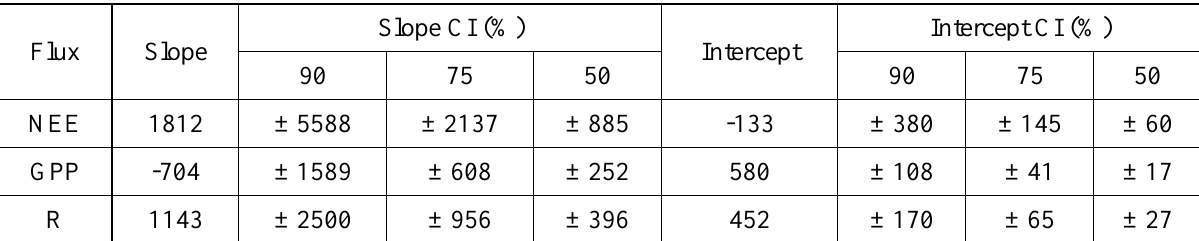
Table 2. Fitted slope and intercept coefficients with confidence intervals at 90, 75 and 50 %. Fits are provided for dependent variables (y): NEE, GPP and R. The independent variable (x) was the reciprocal of the time since restoration in years ( i.e . 1/Time), e.g. y = slope / Time + Intercept. For the Cross Lochs (near-pristine) site, the time since restoration was set at